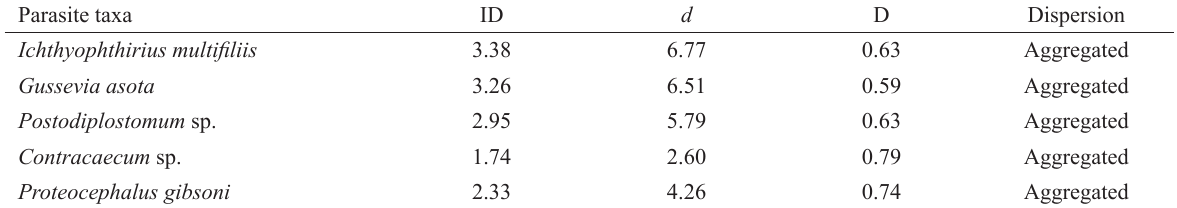
Index of dispersion (ID), d- statistic and discrepancy index (D) for the parasite infracommunities of Astronotus ocellatus from the Fortaleza Igarapé basin, in the eastern Amazon (Brazil). Parasite taxa